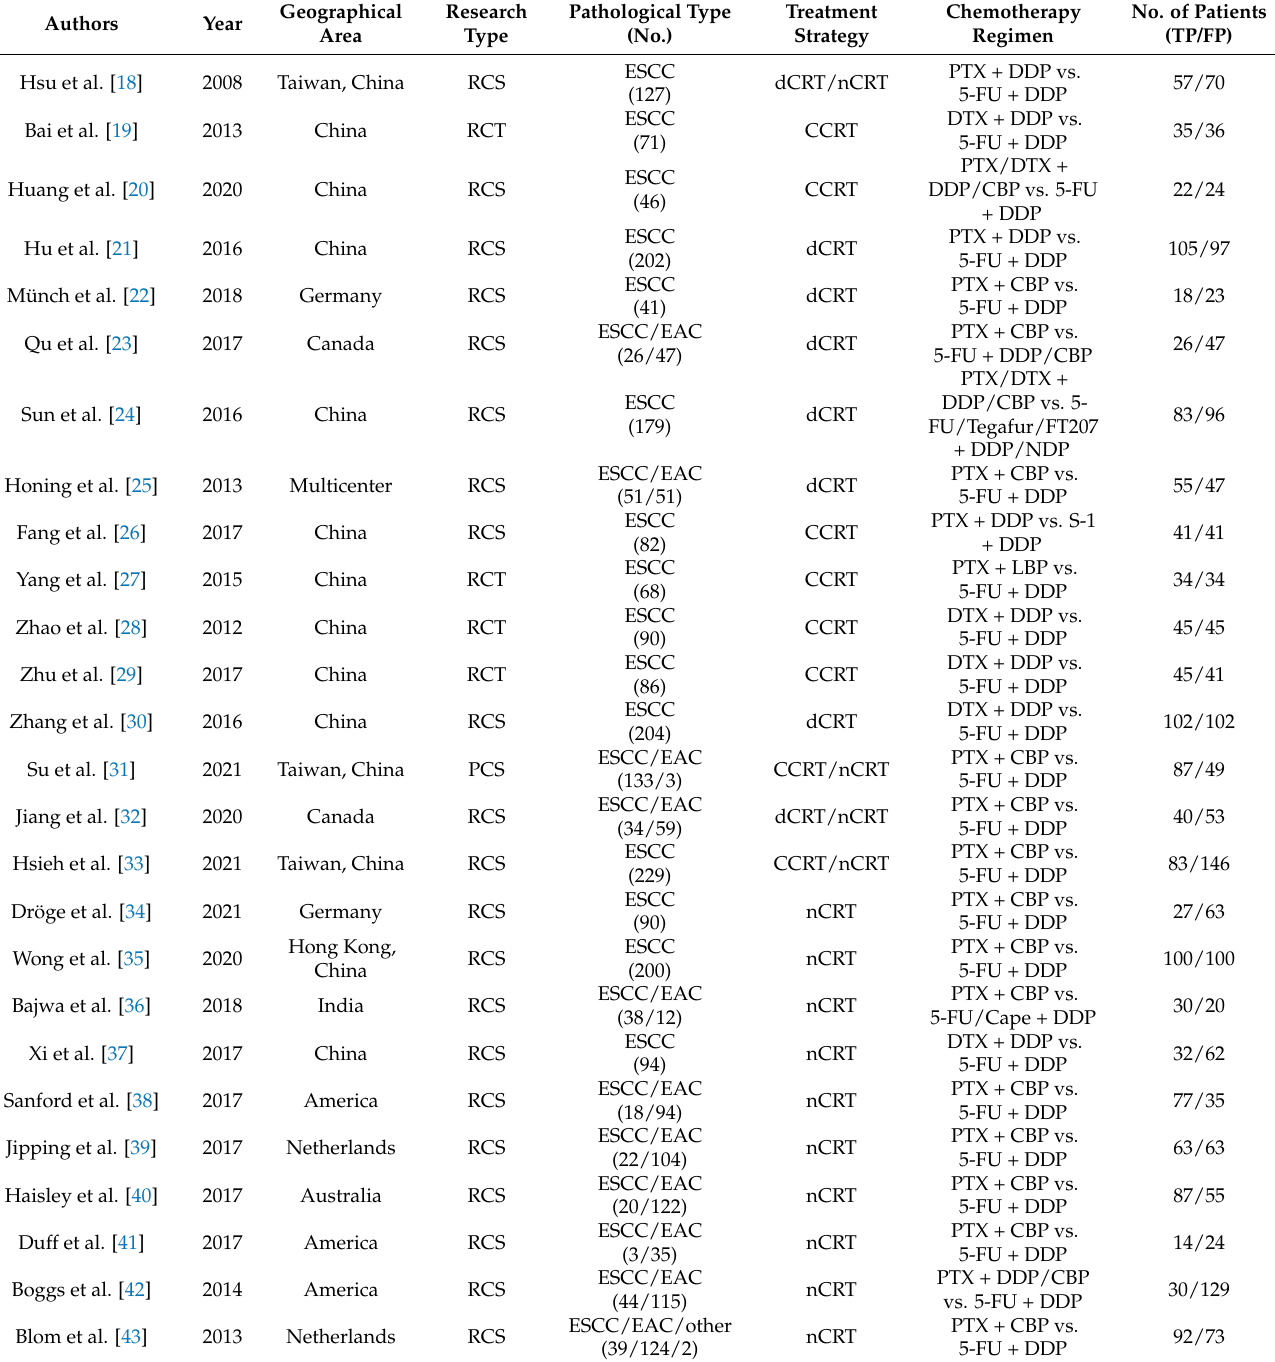
Table 1. Characteristics of 31 selected studies included in the systematic review and